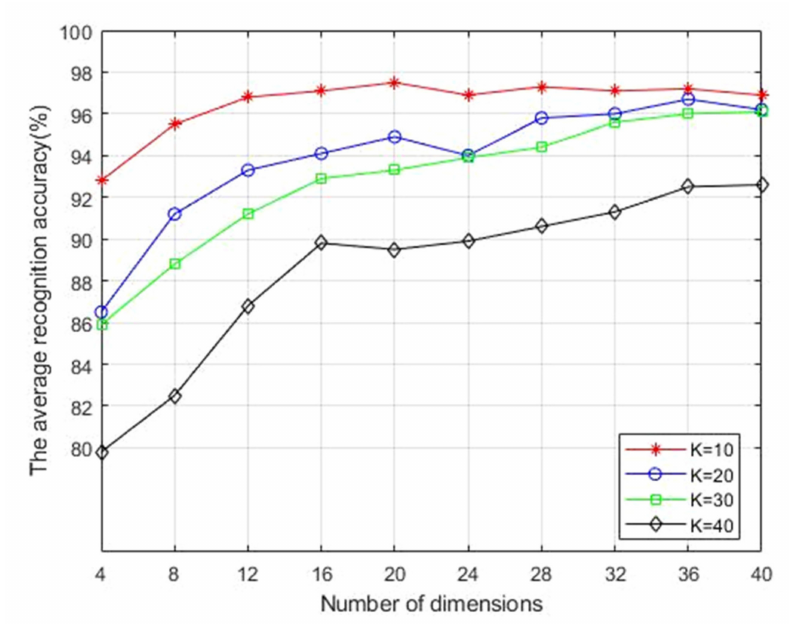
Figure 4. Average recognition accuracy (%) of the 2DESDLPP algorithm corresponding to different K values with feature dimensions when the training sample in the AR database is 6.